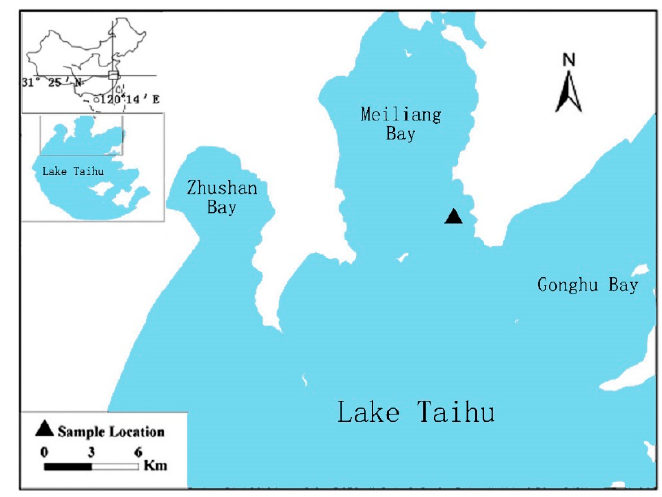
Figure 1. Location of Lake Taihu, China and ▲ indicates the location of the sample collection point.